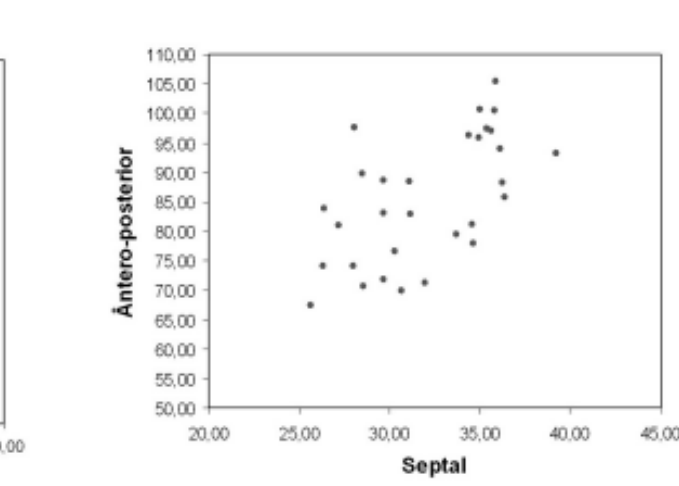
Fig. 5 - Tamanhos do segmento ântero-posterior e segmento septal no anel tricuspídeo retificado (em